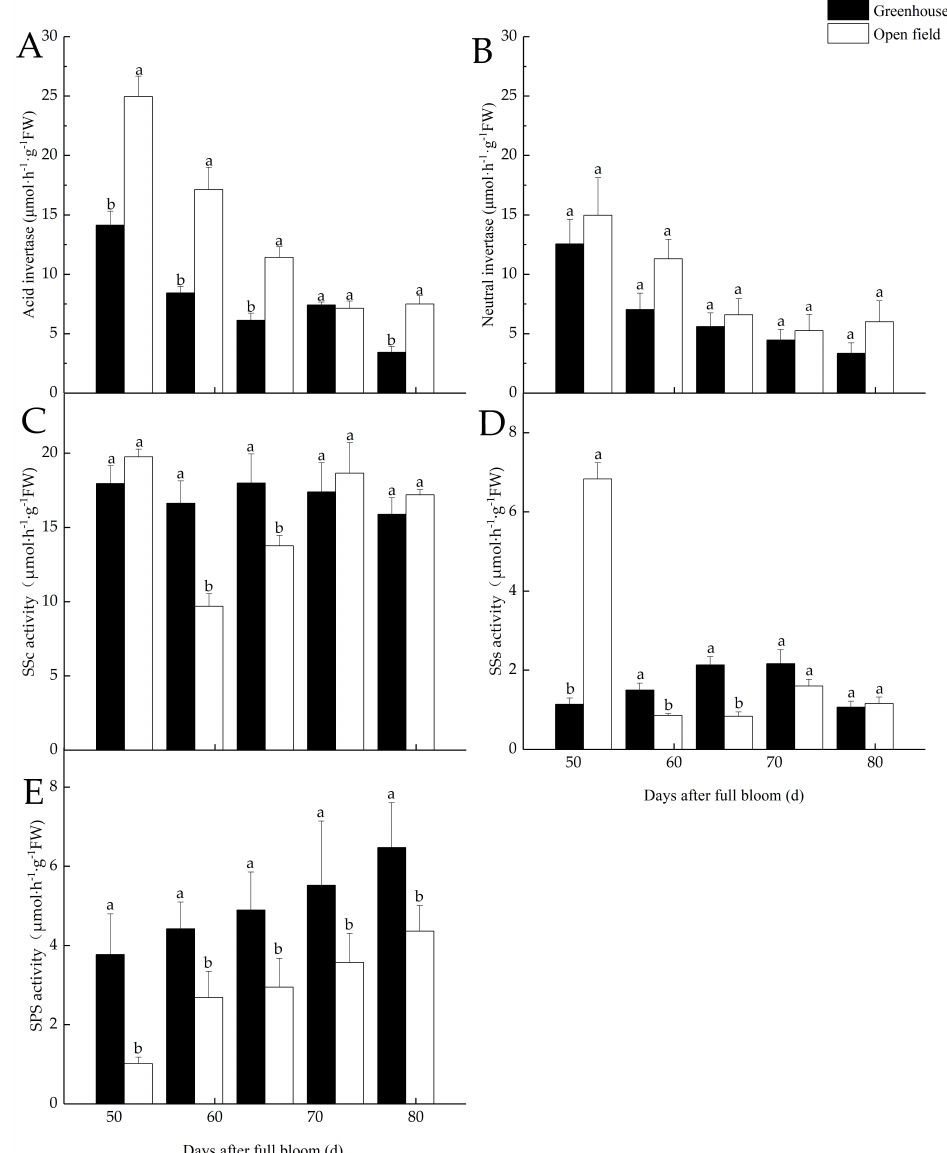
Figure 5. Sucrose metabolizing enzymes in bayberry fruit under different cultivation conditions. ( A ) Acid invertase activities of the fruits during bayberry developmental stages. ( B ) Neutral invertase activities of the fruits during bayberry developmental stages. ( C , D ) SS activities of the fruits during bayberry developmental stages. ( E ) SPS activities of the fruits during bayberry developmental stages. Different lowercase letters indicate significant difference ( p <